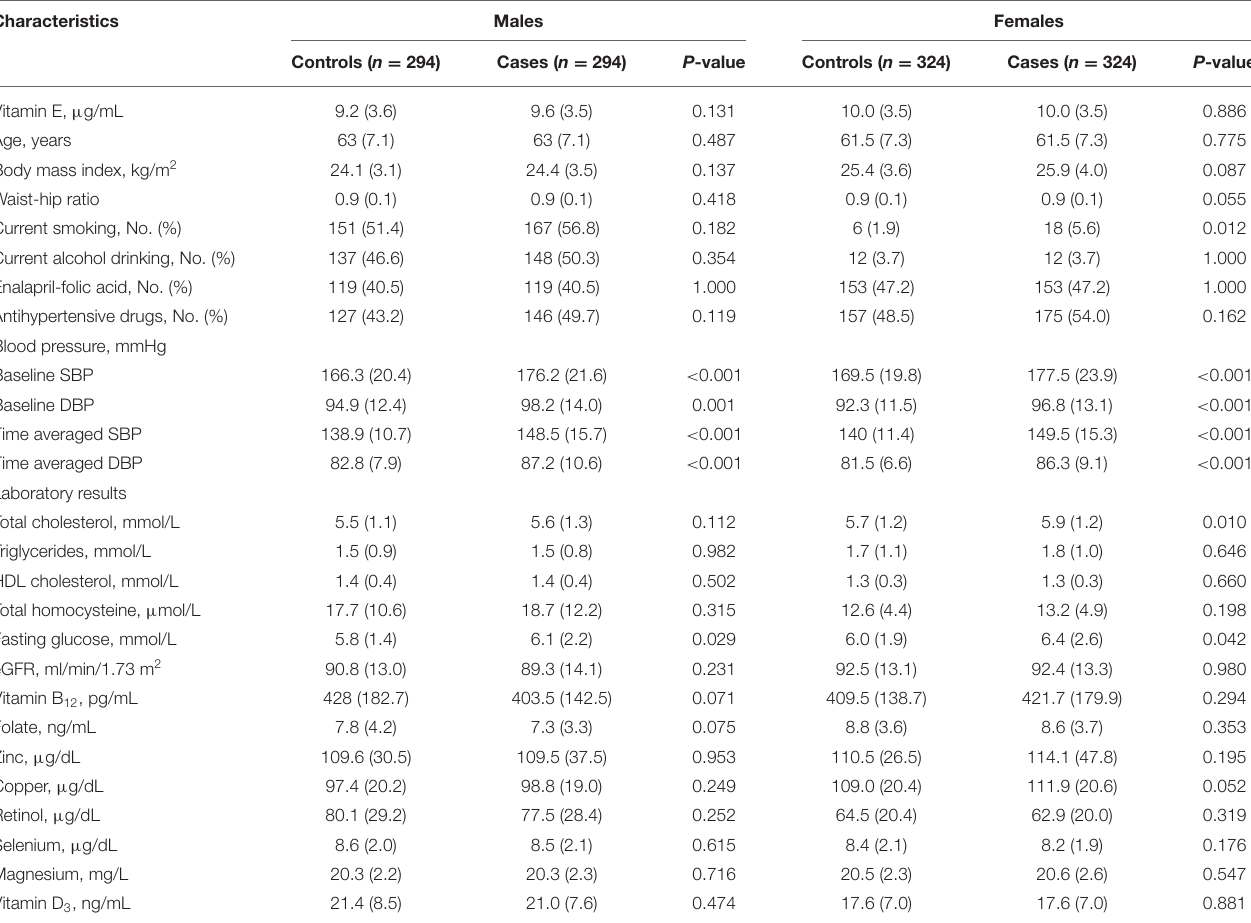
TABLE 1 | Characteristics of stroke cases and control subjects by sex * .